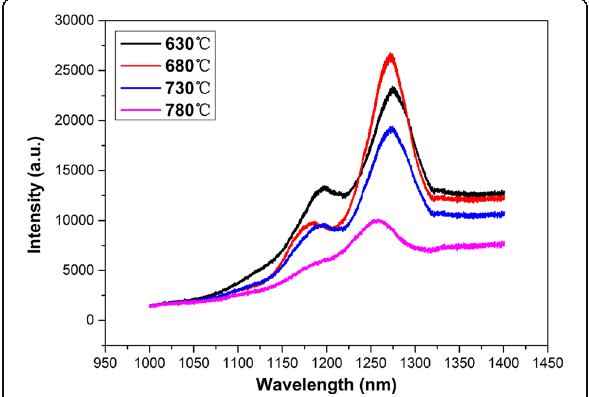
Fig. 1 Comparison of photoluminescence (PL) spectra of epitaxial wafers under different annealing temperature